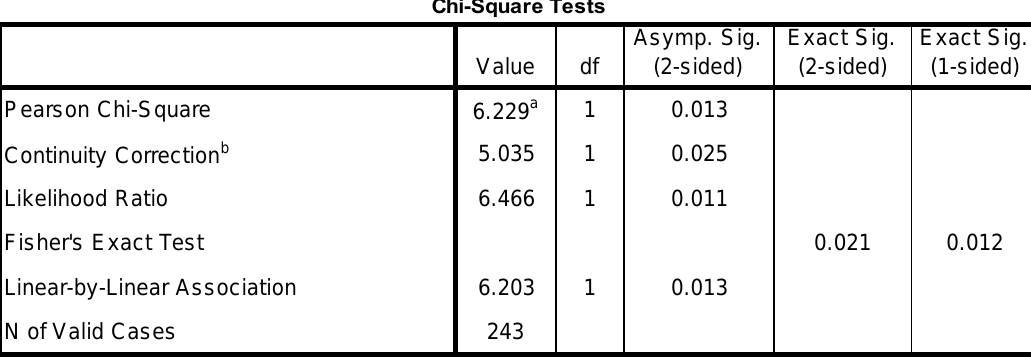
Chi-Square Test: Computer Exposure Vs Attitude Towards